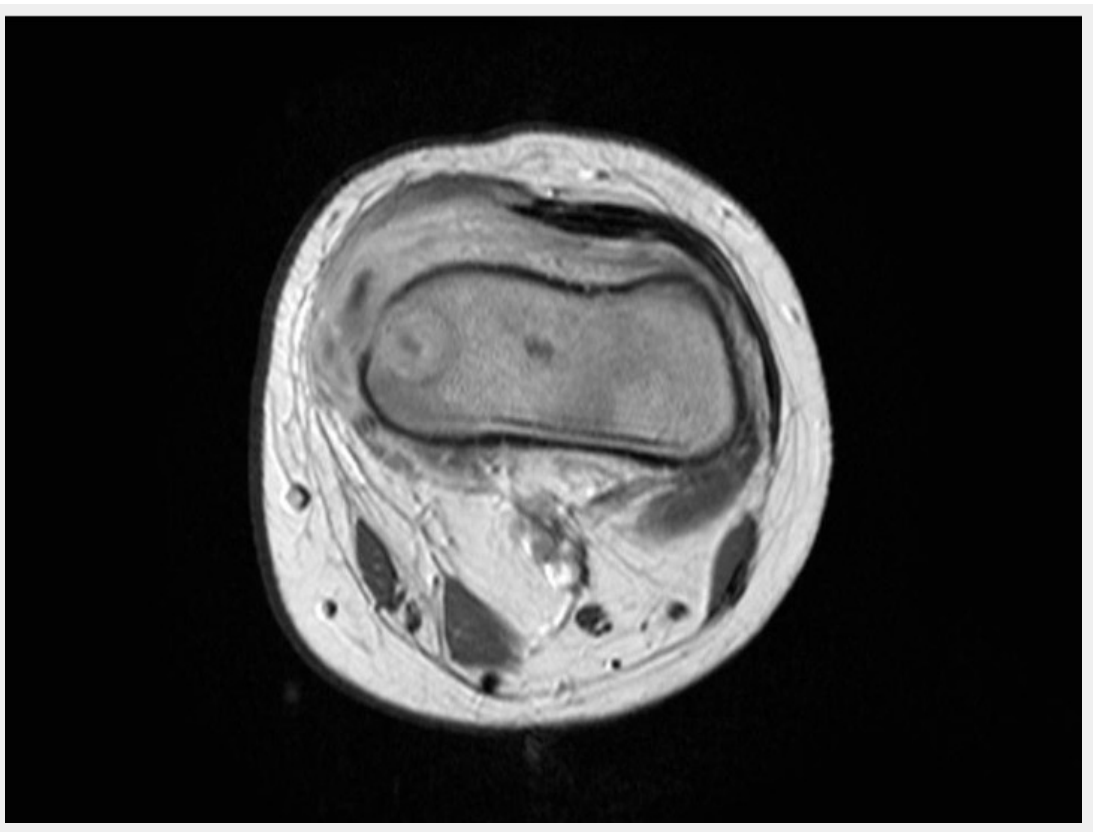
Figure 3 Magnetic resonance imaging (MRI) of the distal femur of a 17-month-old boy, which showed a normal appearance on plain radiographs. MRI demonstrated a lytic lesion of the distal femoral epiphysis with an important abscess of the soft surrounding tissues. Specific cultures confirmed